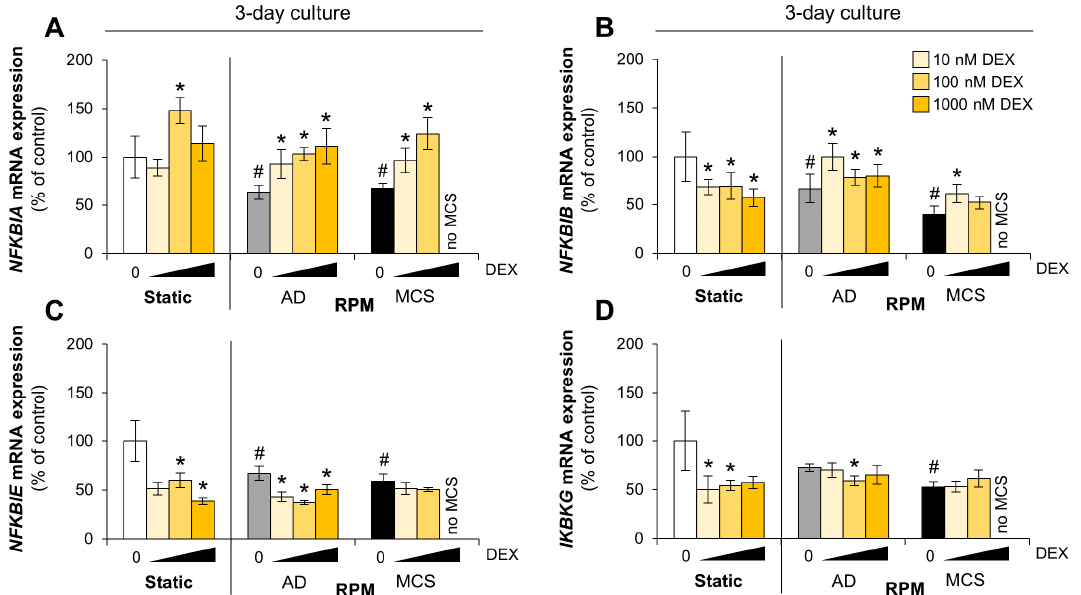
Figure 4. Effect of DEX on NF- κ B regulators in FTC-133 cells. ( A ) NFKBIA mRNA expression; ( B )